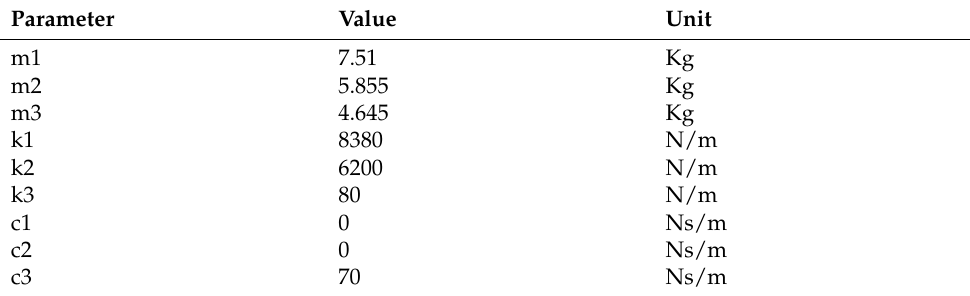
Table 5. Parameters of DSA250 pantograph.